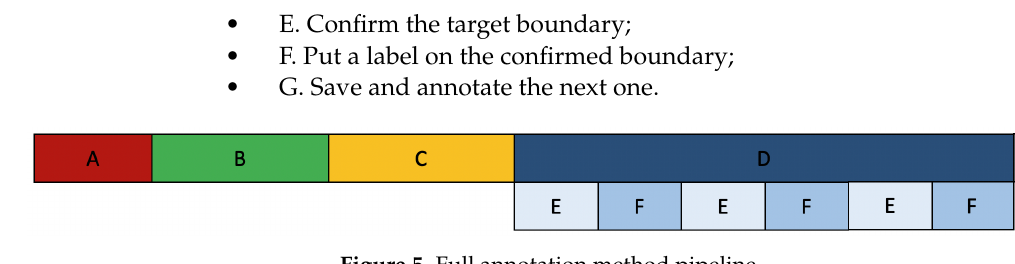
Figure 5. Full annotation method pipeline.